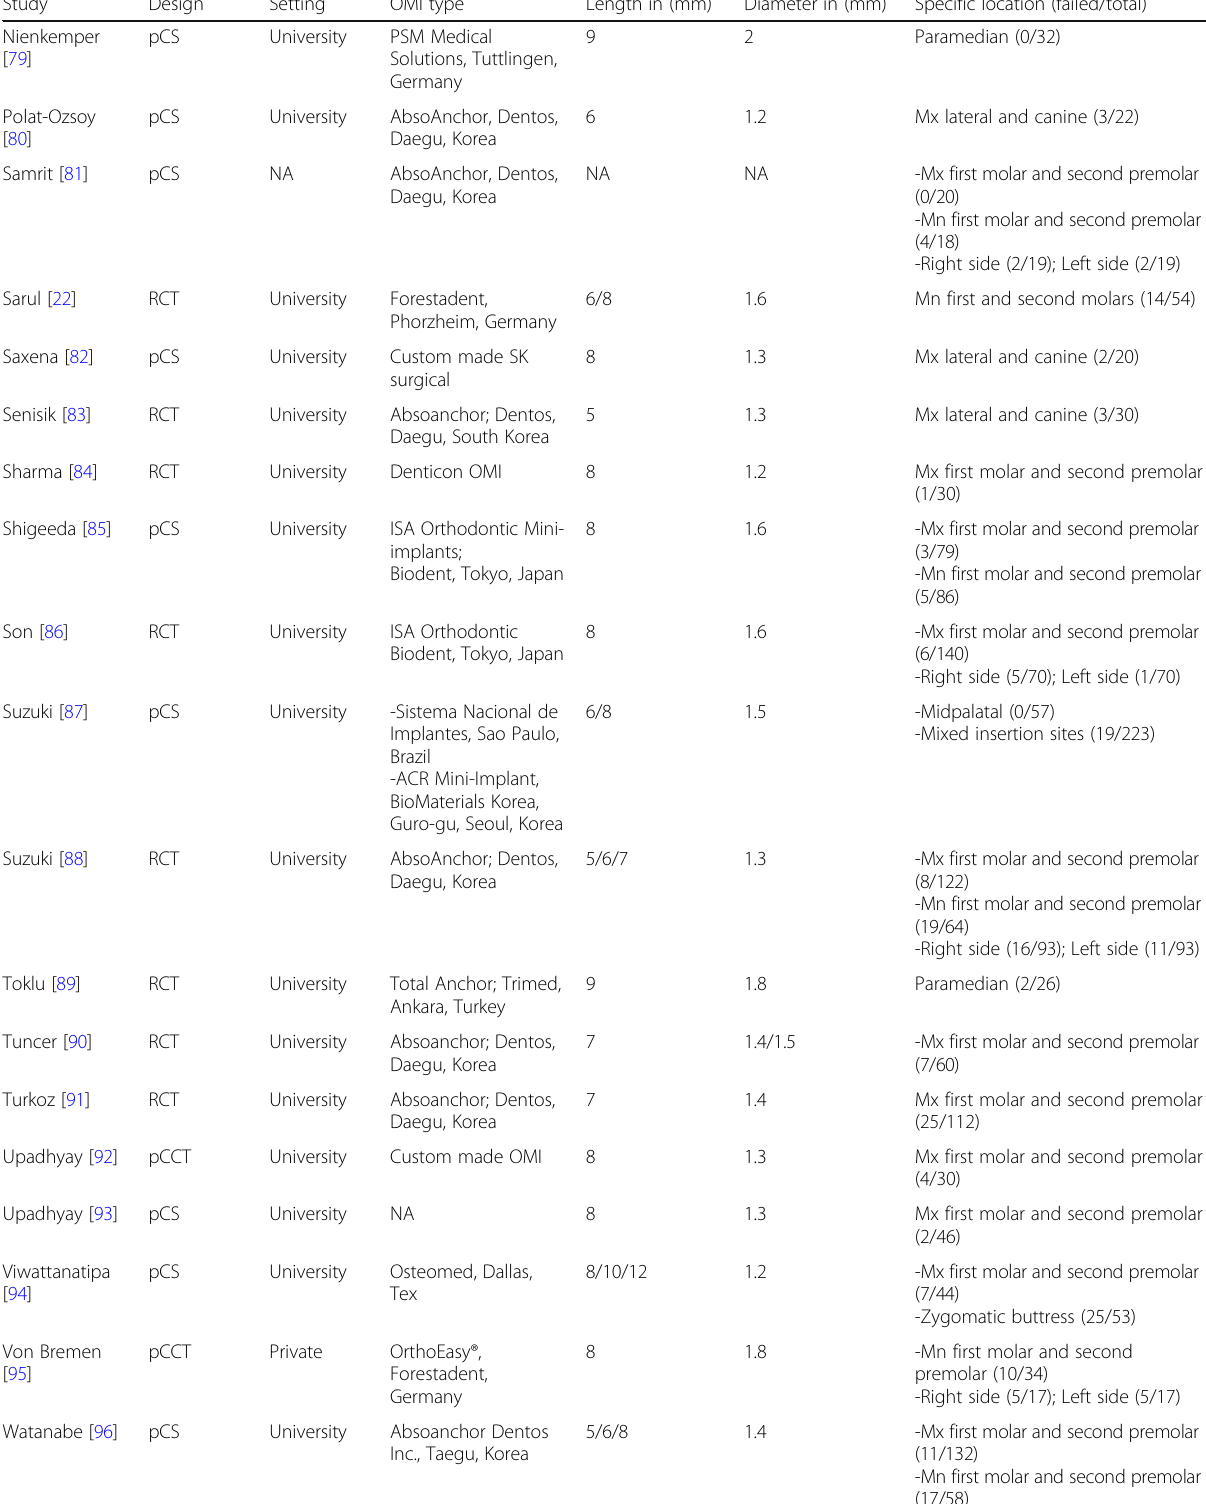
Table 1 Characteristics of the included studies